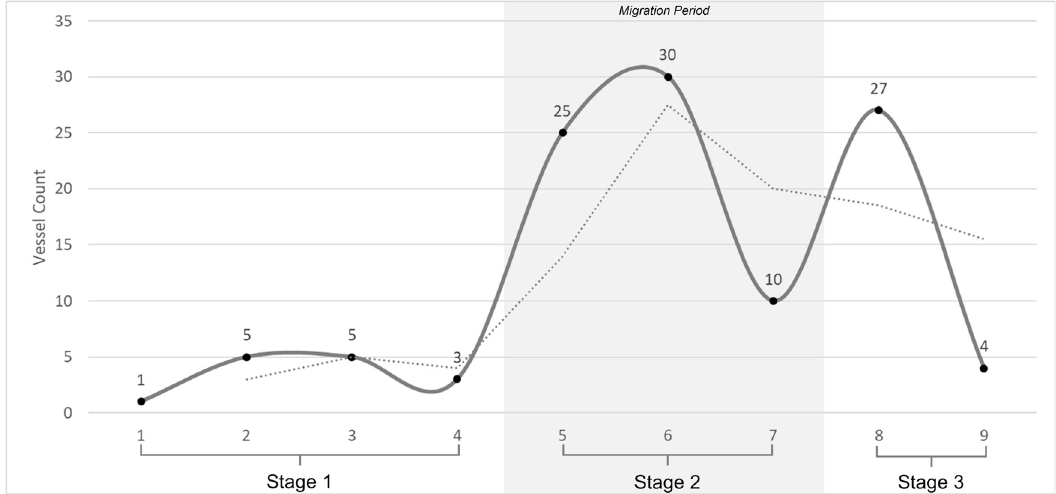
Figure 5: Distribution of tsubo vessels across each temporal stage ( stage 1; c = 14, stage 2; c = 65, and stage 3; c = 31 ) ; dotted line represents the moving average over the entire